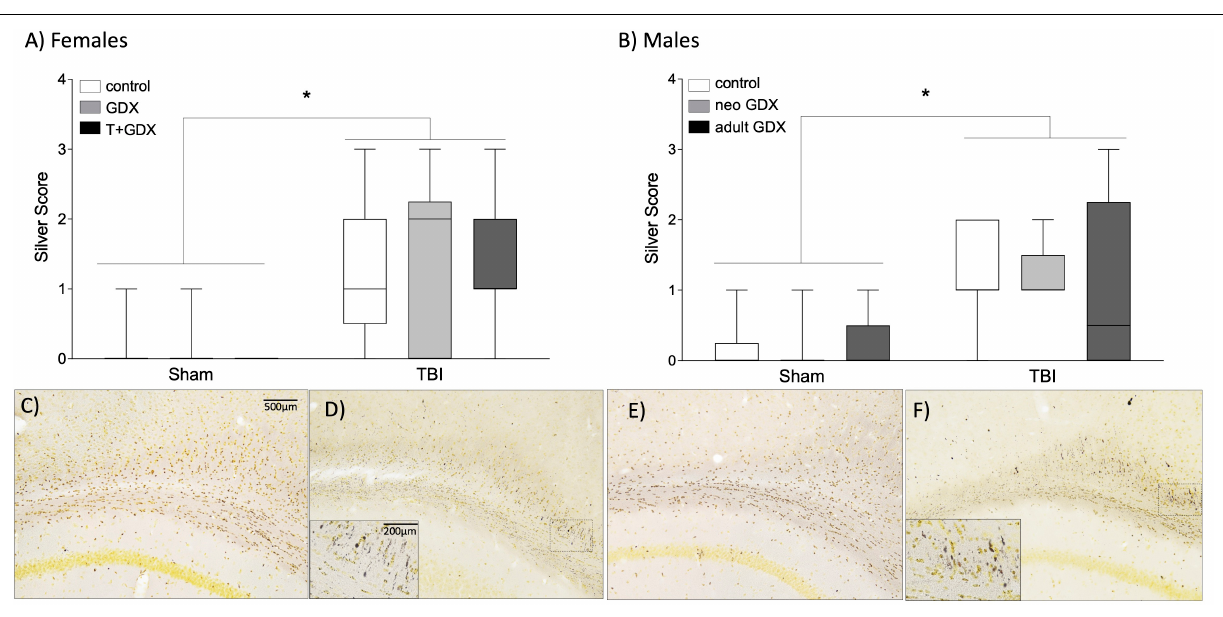
FIGURE 3 | Axon degeneration. Axonal damage scores based on silver staining in (A) female and (B) male mice. An asterisk (*) indicates statistically significant difference from sham injured mice, ANOVA p < 0.05. Boxplots show representative range (minimum and maximum), first quartile, median, and third quartile data for each group. Representative photomicrographs are shown for (C) female sham, (D) female TBI, (E) male sham, and (F) male TBI. Scale bar = 500 µ m, inset scale bar = 200 µ